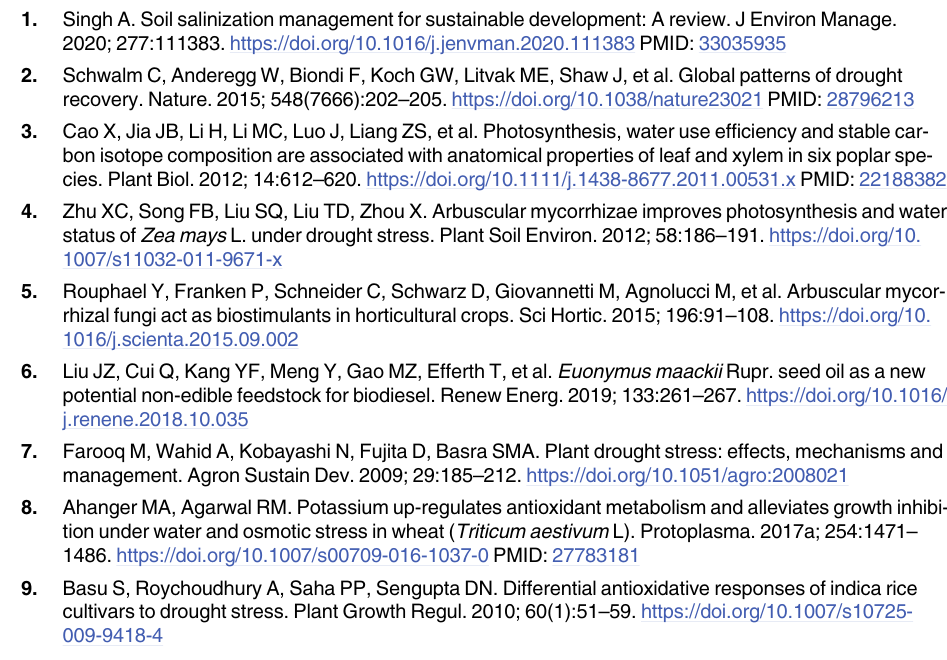
S1 Table. Detail on the statistical